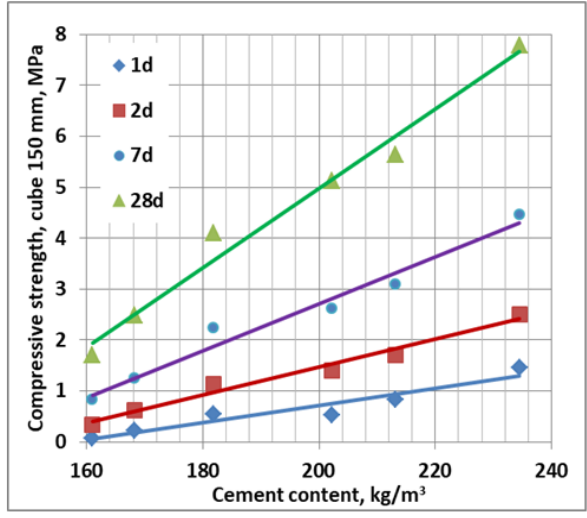
Figure 2. Strength of the applied pumice concrete vs. cement content. The thermal conductivity coefficient of dry oven pumice concrete is λ 10dry = 0.5–0.7 W/(m K).